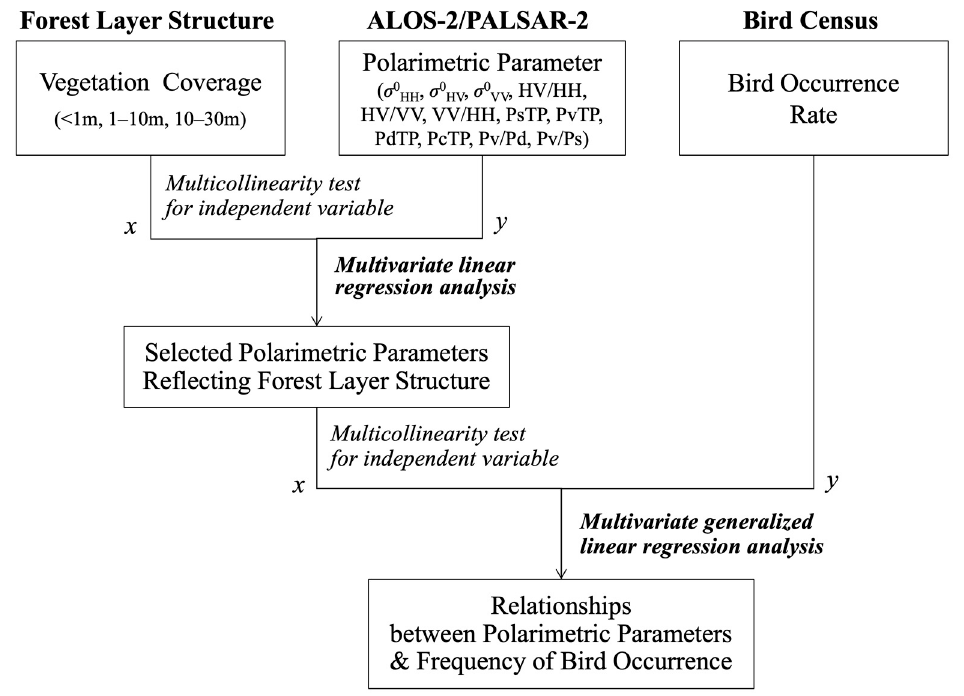
Figure 4. Analysis flow chart.